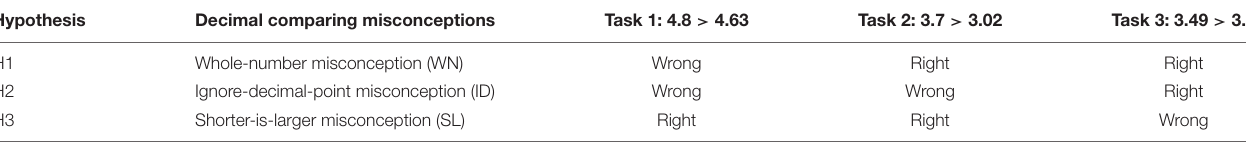
TABLE 3 | Pattern of most likely response (evidence E ) of each task under the condition of a student’s misconception (hypothesis H ). Hypothesis Decimal comparing